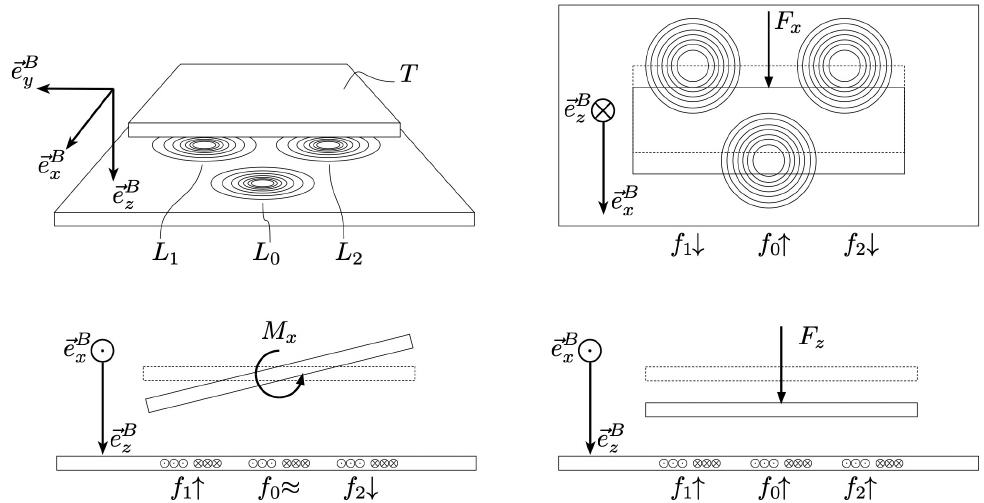
Figure 4. Working principle for 3D load detection using three coils. Here, a forward shear force F x will cause a change in f 0 , and the opposite change in f 1 and f 2 . Torque around the x -axis M x would cause a change in f 1 and the opposite change in f 2 , with f 0 remaining constant. Finally, a normal force F z will cause all frequencies to change equally. With this, all load types can be